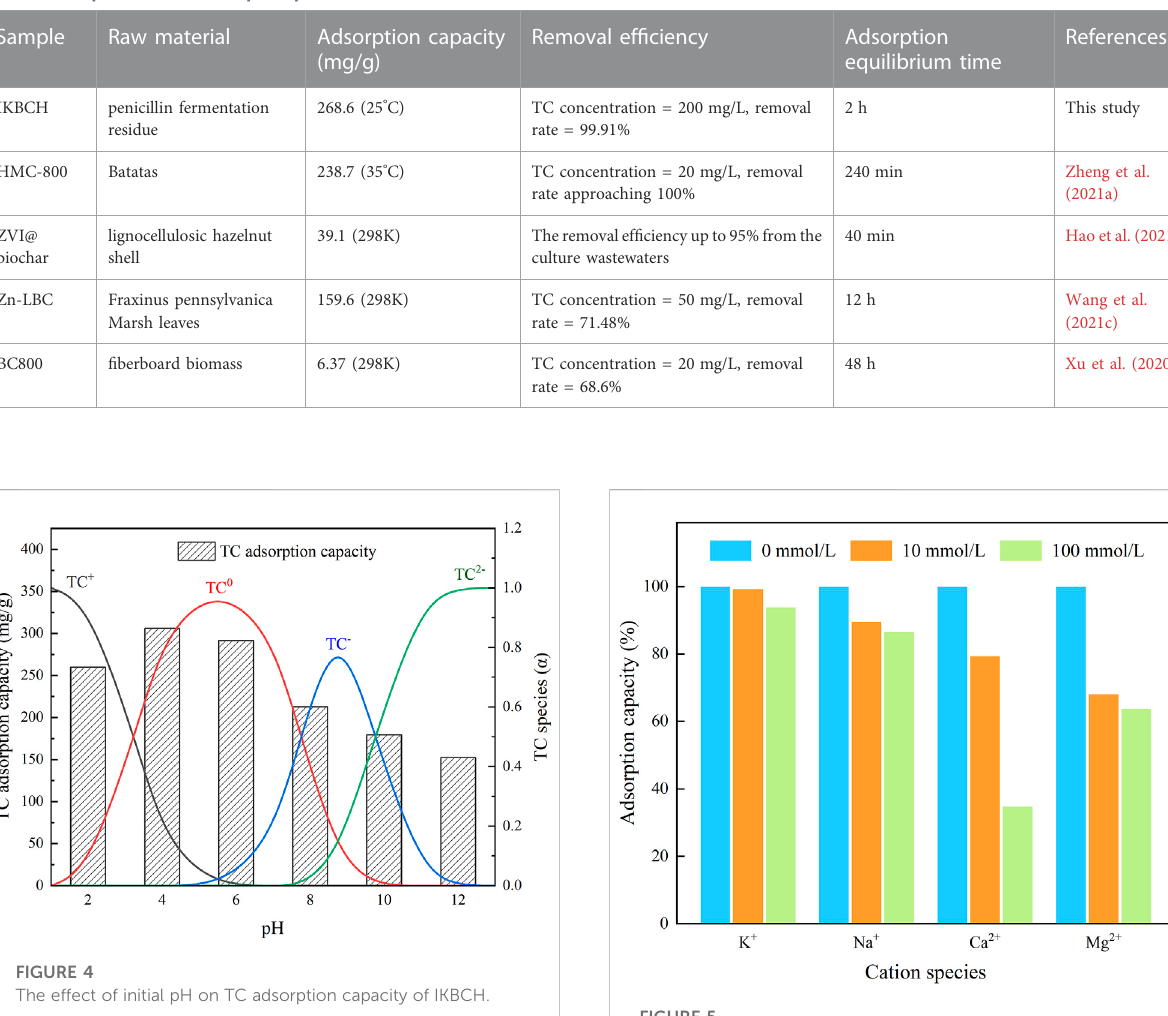
FIGURE 5 Effect of coexisting cations on TC adsorption capacity of